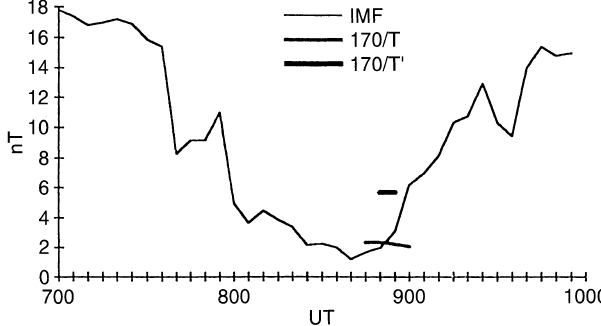
Fig. 13. IMF scalar magnitude during the 3 h centred around the interval 0800–0900 UT, 22 May, and the observed surface pulsations of supposedly UW origin. In this particular case (expressed as B (cid:3) (cid:136) 170 = T (cid:134) , the long-period ( T , about 70–80 s) activity may be of UW origin, the exceptional 30-s activity ( T ’) with constant period at 0847–0849.5 UT may correspond to a somewhat later